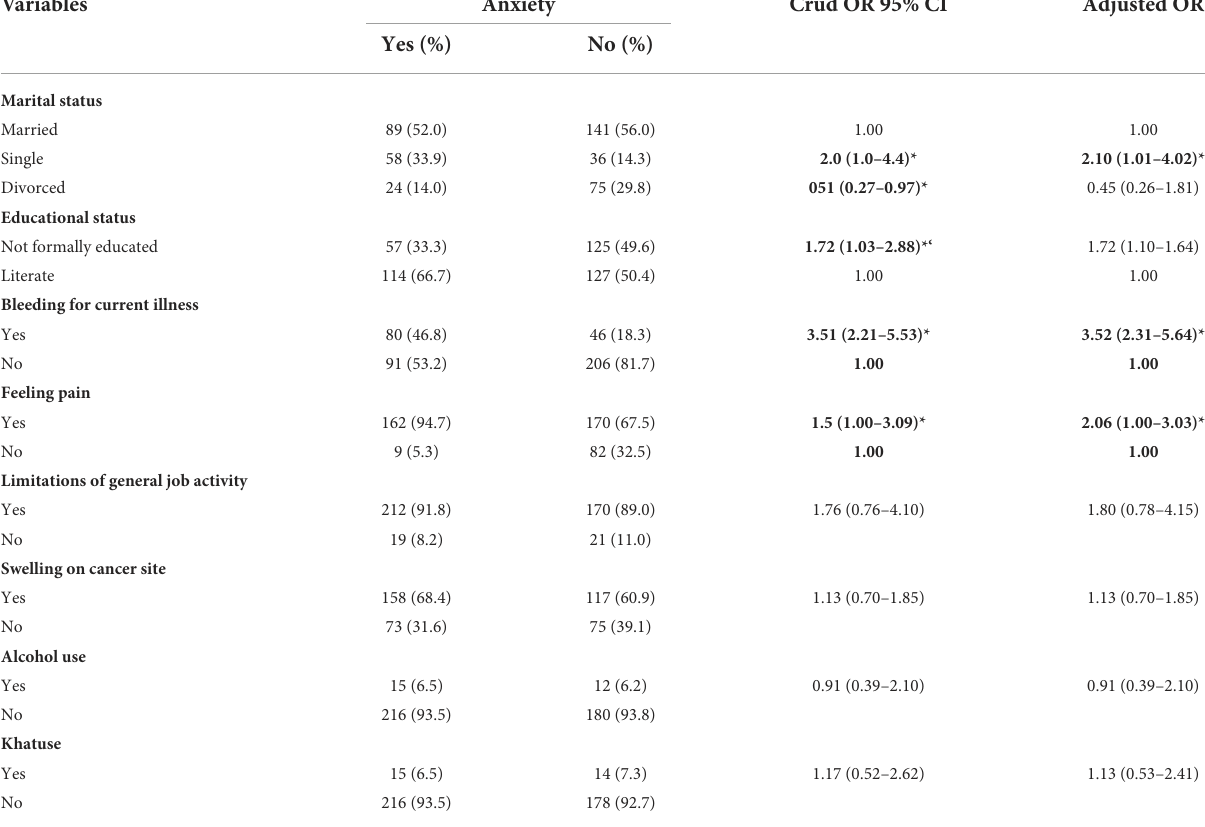
TABLE 3 Bivariate and Multivariate logistic analysis result of Anxiety study subjects among adults patients attending Oncology clinic at Tikur AnbessaHospital, Addis Ababa, Ethiopia, 2018. Variables Anxiety Crud OR 95% CI Adjusted